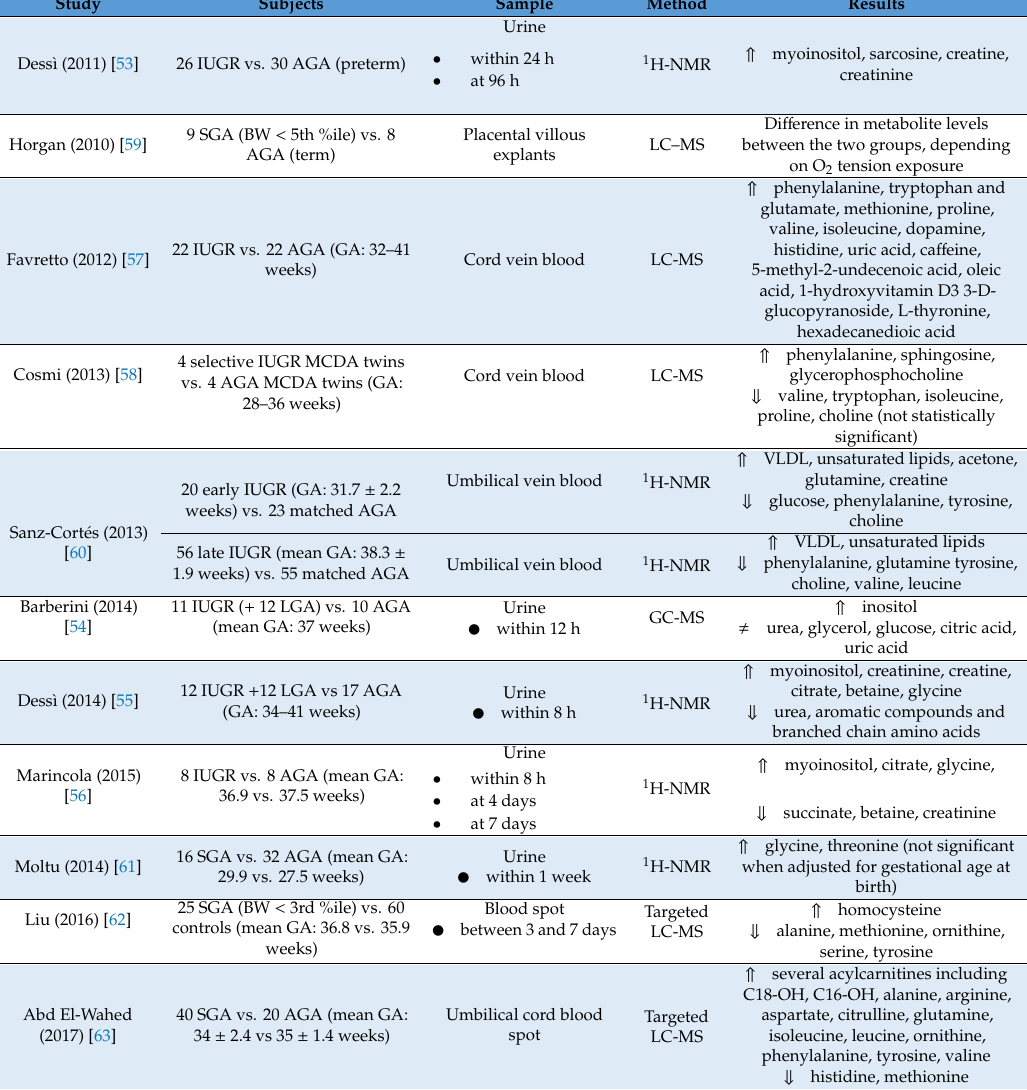
Table 1. Postnatal metabolomic studies on fetal growth